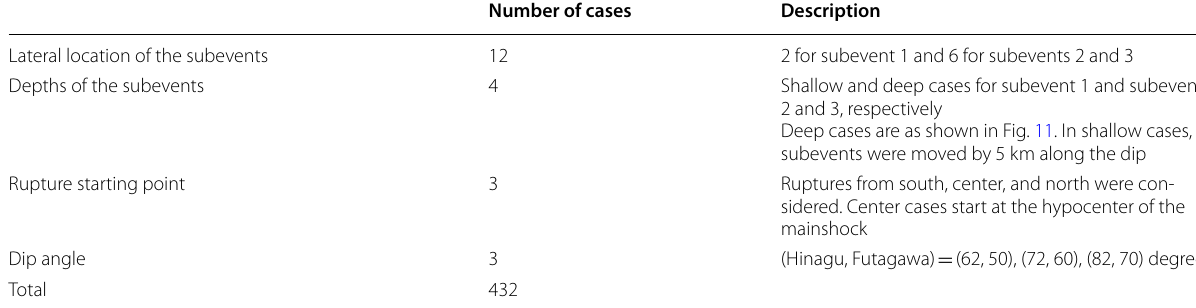
Table 5 Prediction sensitivity to the rupture